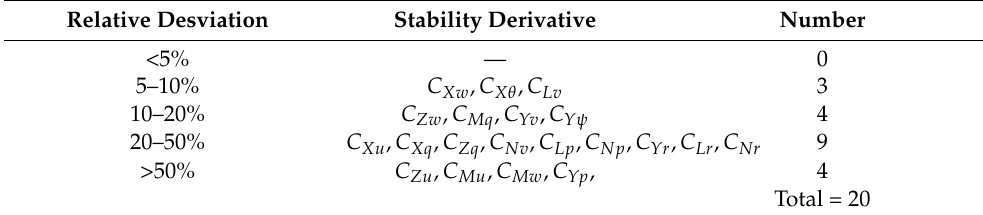
Table 38. Comparison of consistency of stability derivatives